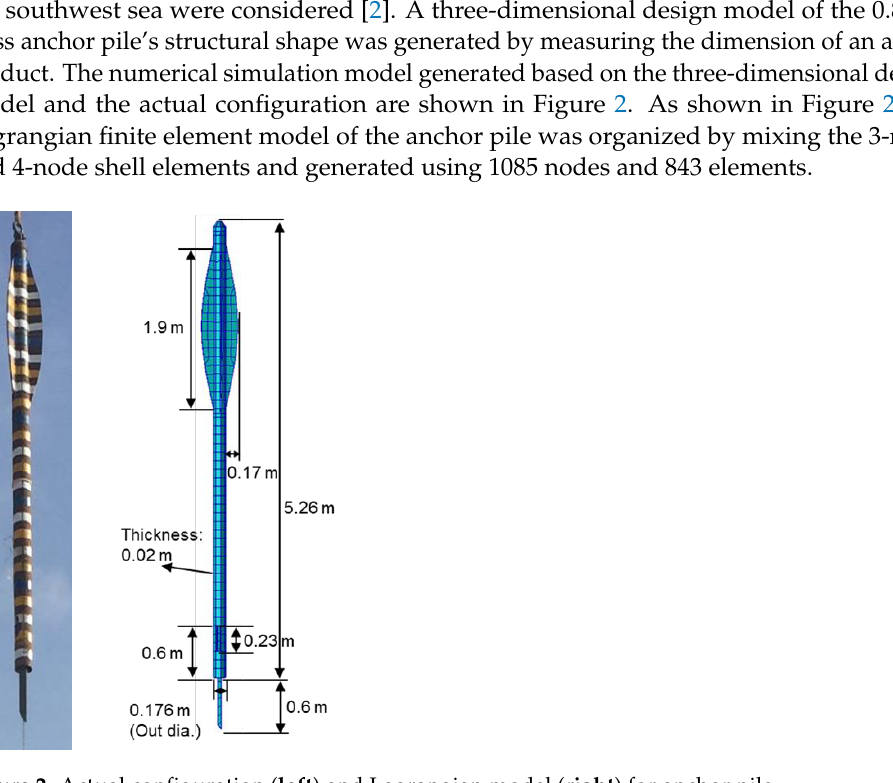
Figure 2. Actual configuration ( left ) and Lagrangian model ( right ) for anchor pile. To reflect the material properties of the anchor pile, which is made of a general steel, the property values of 7850 kg/m 3 , 210 Gpa, and 0.3 were applied as the density, modulus of elasticity, and the Poisson’s ratio , respectively. In addition, the weight of the generated finite element model was arranged to be same as that of the actual anchor pile. 2.3. Numerical Simulation Model of Soil Penetration The soil penetration numerical simulation model was configured in the same way as the conditions of the field verification test that was conducted to verify the safe depth of burial soil against the drop impact of the anchor pile. The configuration of the soil penetration numerical simulation model is shown in Figure 3. Figure 3. Numerical simulation model of soil penetration.